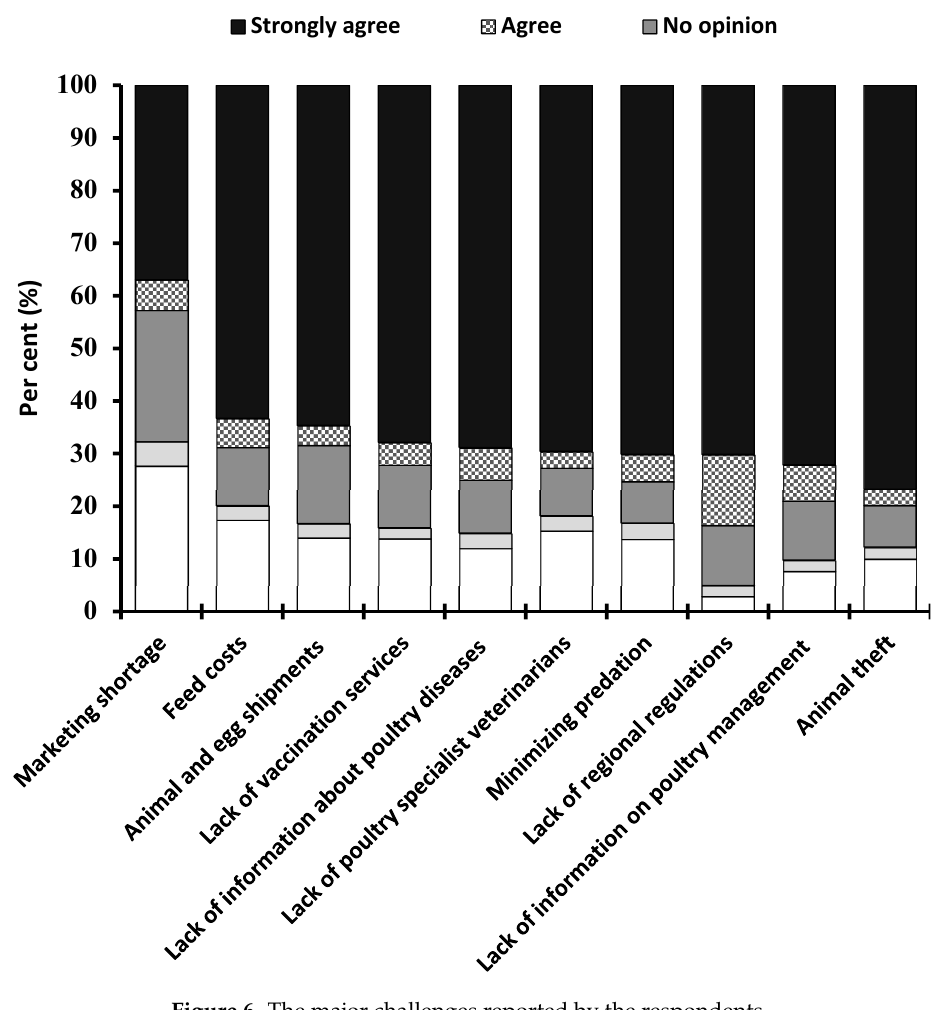
Figure 6. The major challenges reported by the respondents.